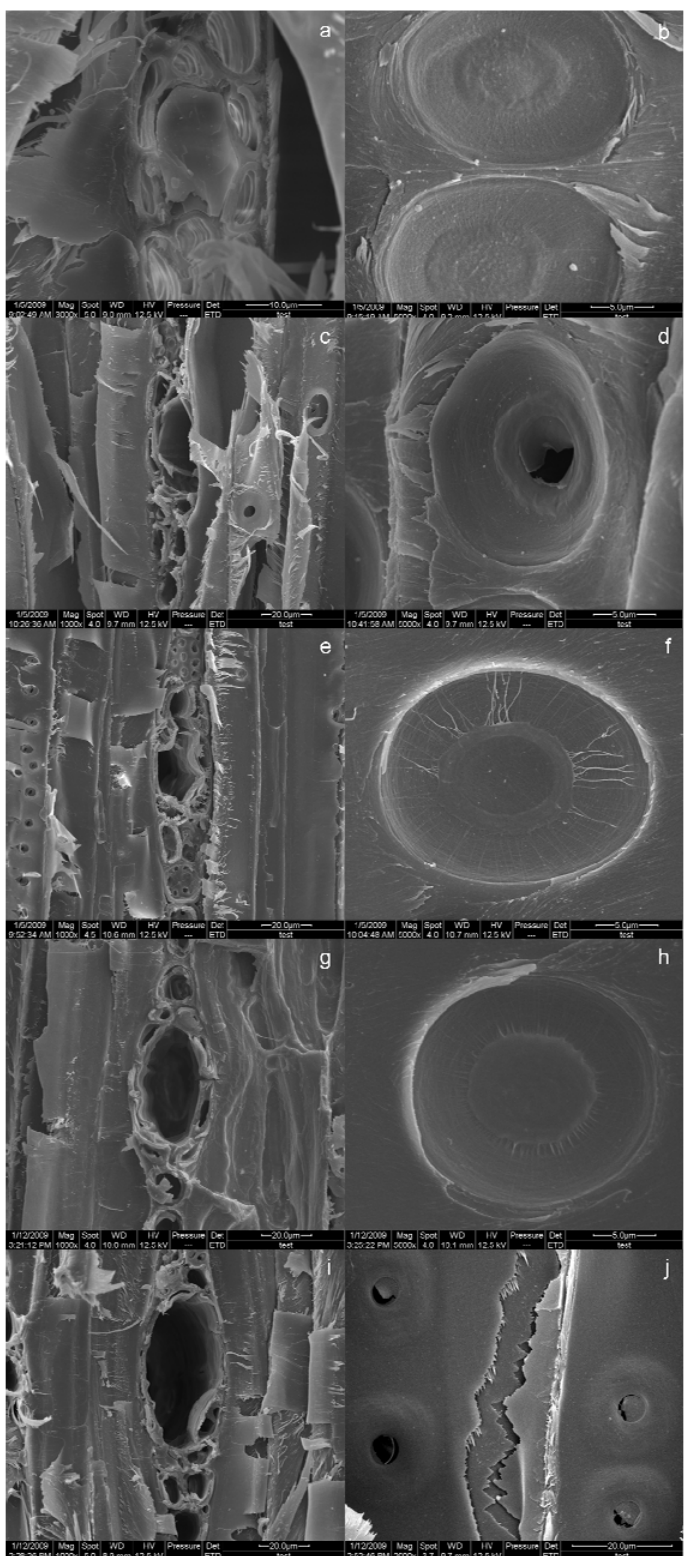
Figure 4. Morphology analysis. Scanning electron microscopy (SEM) images of resin ducts and pits of ( a , b ) raw materials, ( c , d ) the materials treated by program A, ( e , f ) the materials treated by program B, ( g , h ) the materials treated by program E, and ( i , j ) the materials treated by program